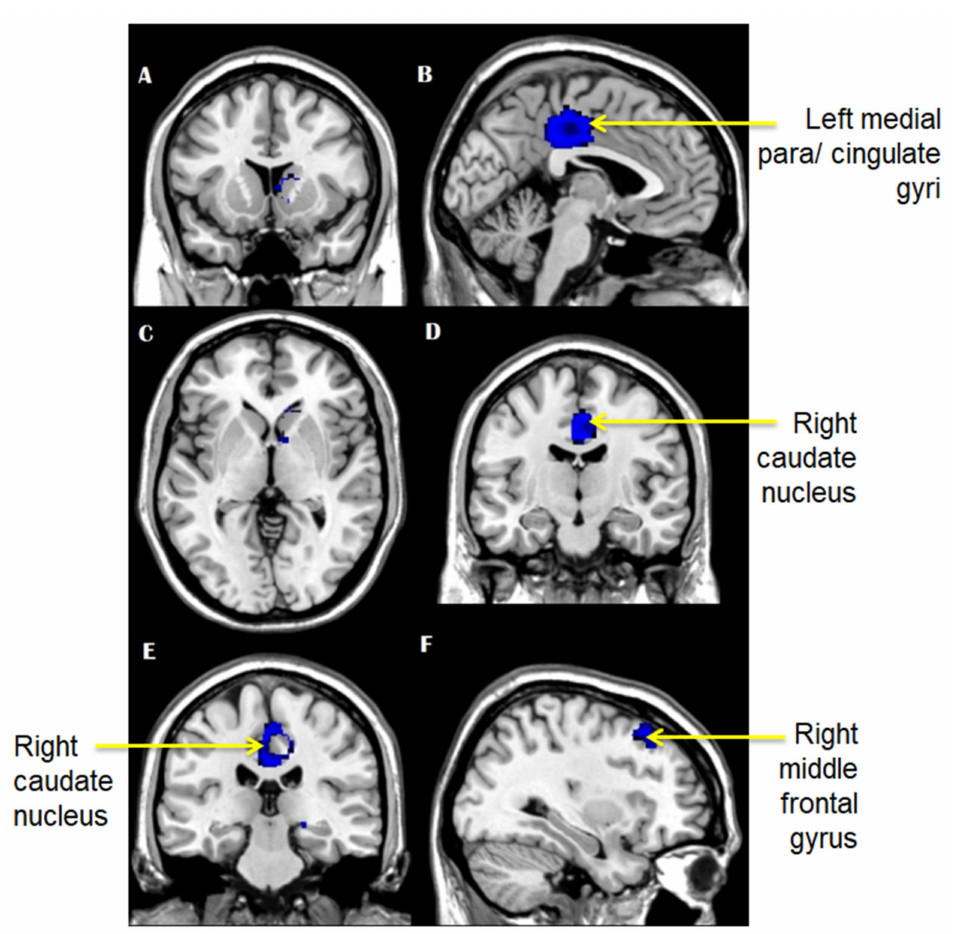
Figure 3. ( A – F ): Brain areas that showed increased grey matter volume in mTBI patients compared with